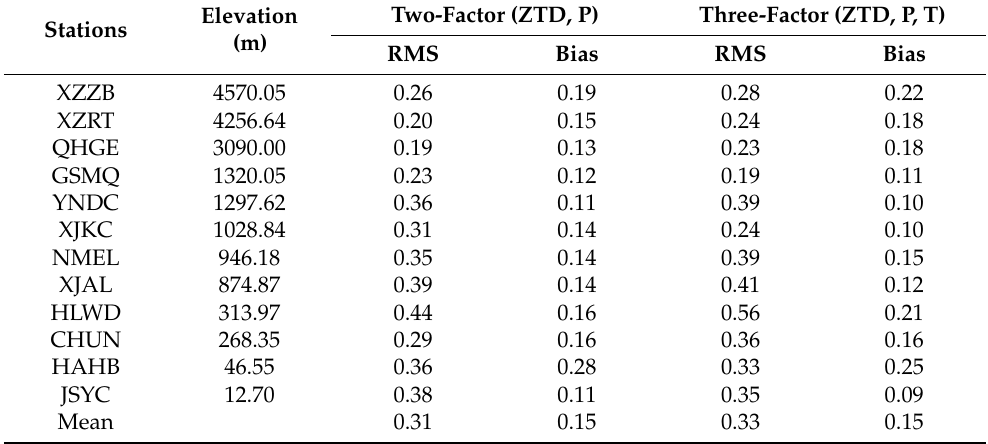
Table 5. The external precision of predicted PWV of verification stations during 2017–2018 (mm). Two-Factor (ZTD, P) Three-Factor (ZTD, P, T) Elevation Stations (m) RMS Bias